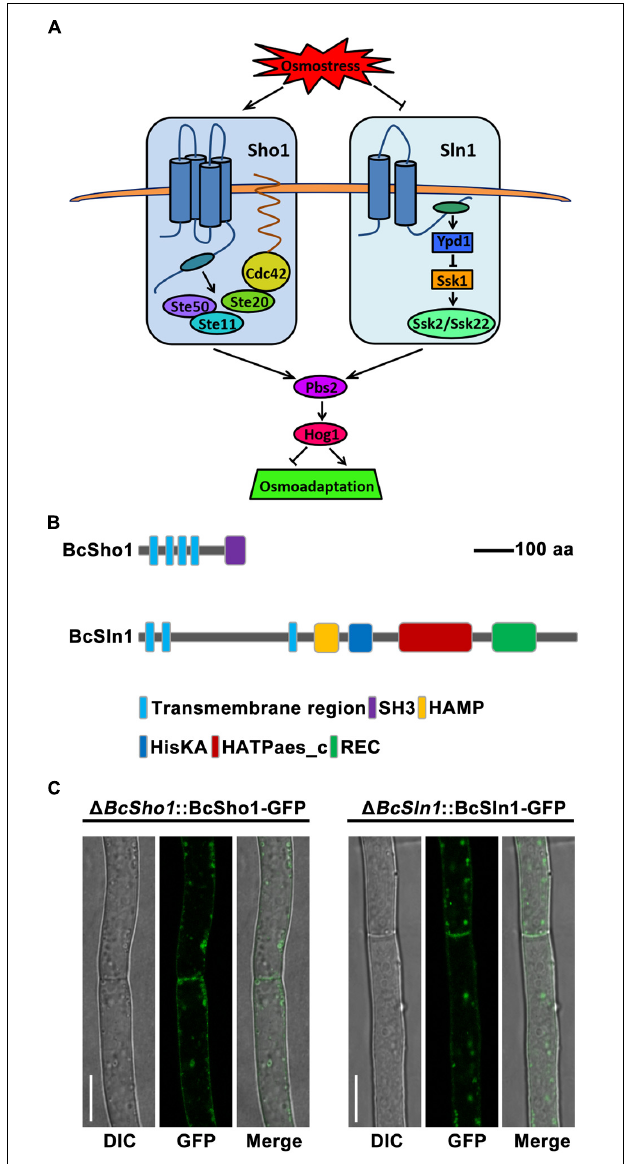
FIGURE 1 | Model of the yeast hyperosmotic-response MAPK pathway. (A) The osmotic signals from Sho1 or Sln1 are transduced by unique components and converge to activate Pbs2. The Sho1 branch requires Cdc42, Ste20, and Ste50 to activate Ste11. The Sln1 protein activates Ssk2 and Ssk22 through Ypd1 and Ssk1. Any of Ste11, Ssk2, or Ssk22 is able to activate Pbs2, which then phosphorylates Hog1, resulting in translocation of Hog1 to the nucleus that regulates responsible genes expression for osmoadaptation. (B) The schematic diagram of Sho1 and Sln1 orthologs in Botrytis cinerea . The functional domains were retrieved in EnsemblFungi (https://fungi.ensembl.org/Botrytis_cinerea/Info/Index). (C) Subcellular localization of BcSho1-GFP and BcSln1-GFP fusion proteins in B. cienrea . Bars, 10 µ m.